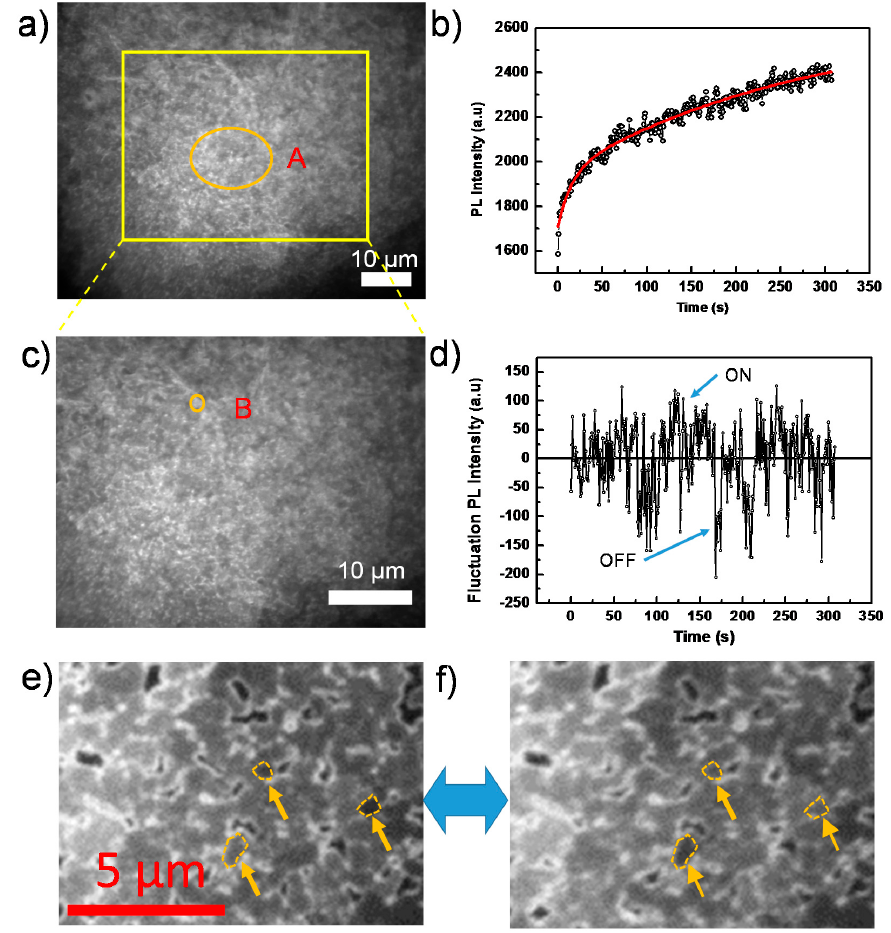
Figure 3. ( a ) Wide-field PL image of a perovskite film taken from a sequence of 400 consecutively-recorded images with an exposure time of 50 ms, an interval time of 500 ms and an excitation intensity of 44 mW/cm 2 ; ( b ) PL intensity trajectory extracted from Area A in the sequence of images in ( a ). The red line is the fit by an exponential function; ( c ) Enlarged view of the yellow square area of ( a ); ( d ) PL intensity trajectory extracted from Area B in ( c ) after subtraction of the exponentially increasing base line; ( e , f ) Individual grains in “ON” and “OFF” states, respectively, indicated by yellow arrows. The overall continuous PL intensity enhancement, as shown in Figure 3b, is superimposed by strong PL intensity fluctuations beyond experimental noise. This behavior is reminiscent of random switching between ON (highly emissive state) and OFF (weakly emissive state) in the emission trajectory, which is known as blinking or PL intermittency [46]. The intermittency behavior is demonstrated in the Supplementary Materials (Figure S3), which shows the long-term OFF state. In addition, the video in the Supplementary Materials also clearly indicates the blinking behavior confined within individual grains. Although the blinking behavior has been observed in perovskite nanocrystals [13,21,47], it is still not fully studied on compact films composed of the densely-packed perovskite grains [15]. To reveal the underling mechanism, we investigate individual grains, thus avoiding averaging over ensembles of grains in the film. Figure 3c displays an enlarged view of the yellow boxed area in Figure 3a, and an individual grain is highlighted by the orange circle labeled with B. As shown in Figure 3d, the PL